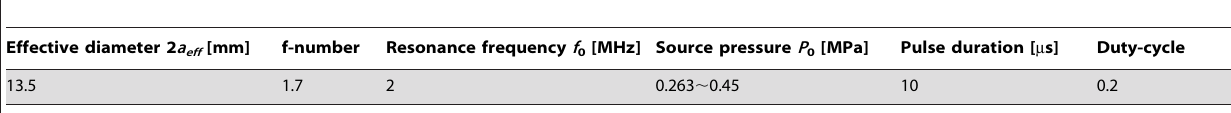
Table 1. The source boundary condition